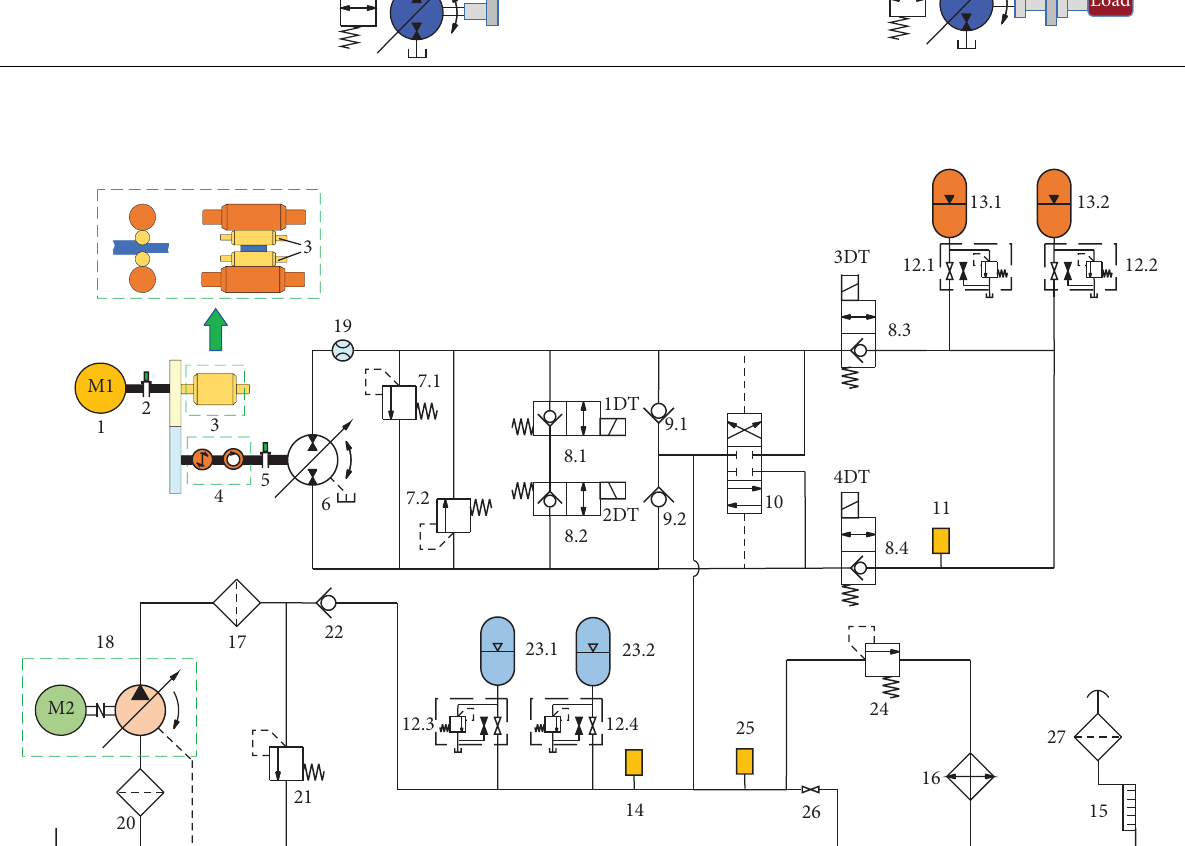
Figure 4: Schematic diagram of electrohydraulic hybrid drive energy recovery system based on the reversible rolling mills: 1, main drive motor M1; 2, electromagnetic clutch YC1; 3, work roll; 4, torque speed sensor; 5, electromagnetic clutch YC2; 6, variable displacement pump/motor; 7.1 and 7.2, 21, 24-relief valves; 8.1–8.4, electromagnetic ball valves; 9.1 and 9.2, 22-one way valve; 10, hydraulic reversing valve; 11, 25-pressure sensor; 12.1–12.4, safety ball valve; 13.1 and 13.2, high-pressure accumulator; 14, temperature sensor; 15, liquid level gauge; 16, cooler; 17, high-pressure oil flter; 18, oil pump motor unit (M2 is the drive motor for the oil refll pump); 19, fowmeter; 20, oil suction flter; 23.1 and 23.2, low-pressure accumulator; 26, shut-of